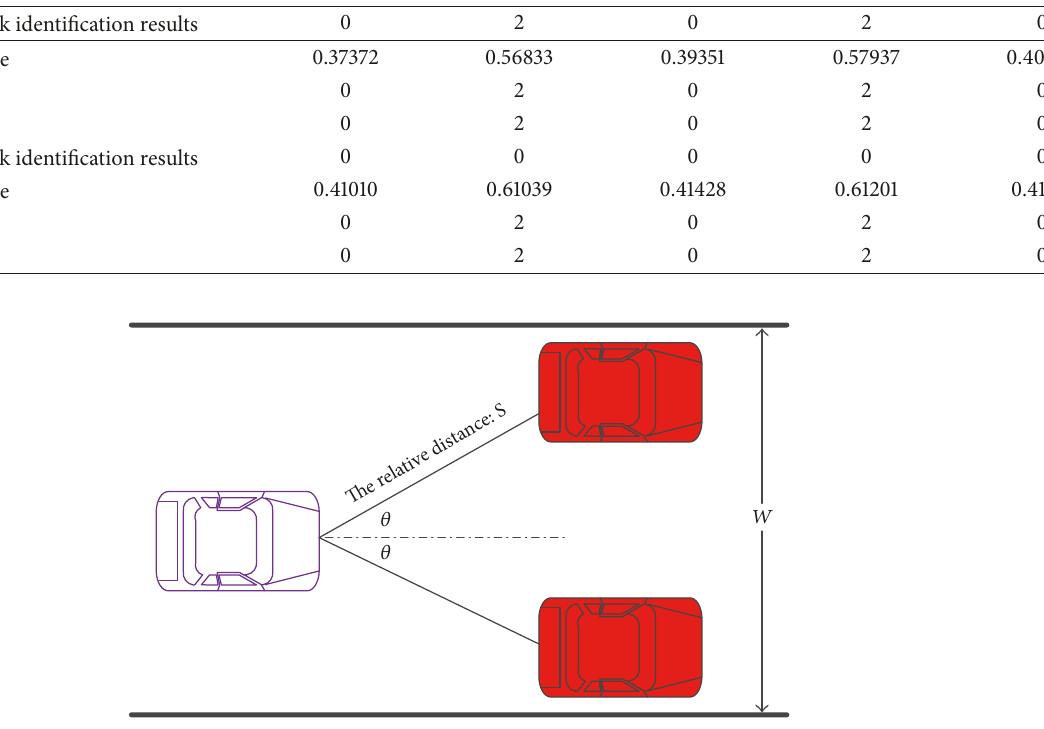
Figure 10: Relative motion states between the ego vehicle and the target vehicles.